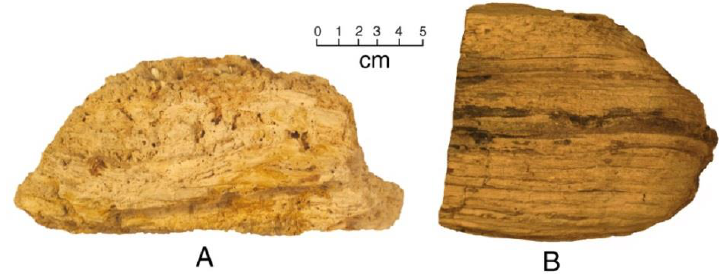
Figure 1. Woods mineralized with calcite. ( A ) Middle Pleistocene mangrove root, Acicennica nitida , Sarasota County, Florida, USA; ( B ) Late Cretaceous wood, Nanaimo Group, Vancouver Island, British Columbia, Canada.